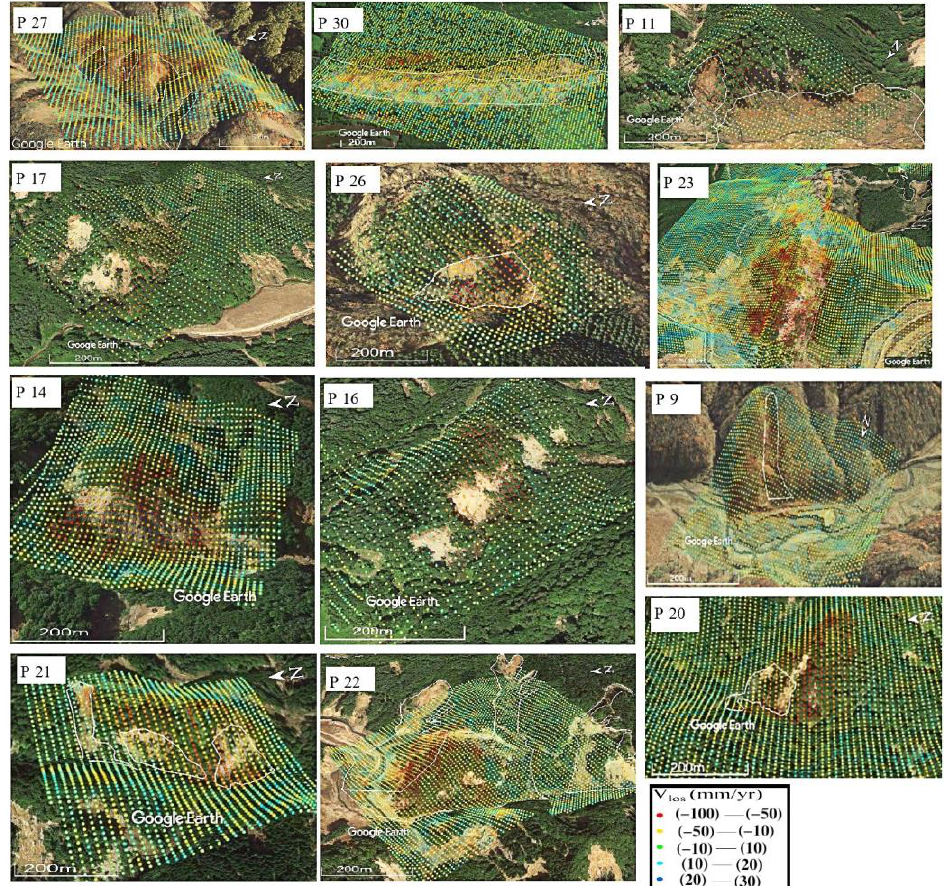
Figure 6. SBAS-InSAR monitoring deformation and optical image interpretation of slow-moving landslides. White lines represent co-seismic earthquake-induced landslide, obtained from Authority of Japan (GSI).